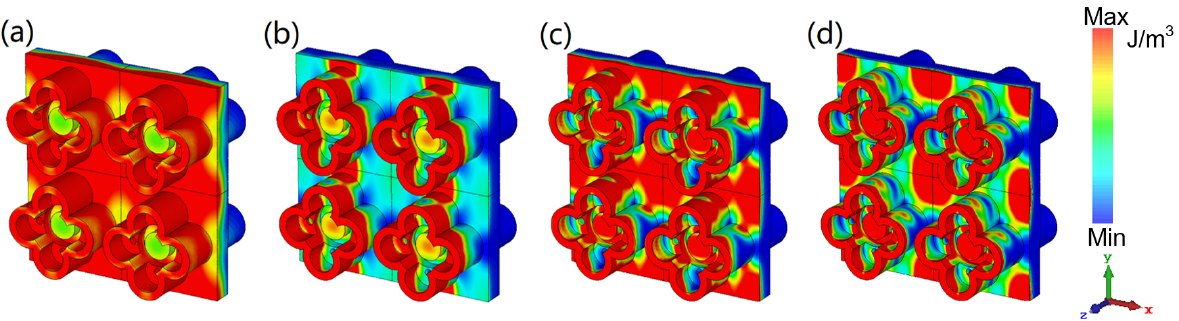
Figure 7. The magnetic field energy density of water layer at ( a ) 6.86 GHz; ( b ) 16.34 GHz; ( c ) 24.72 GHz; ( d ) 40 GHz.